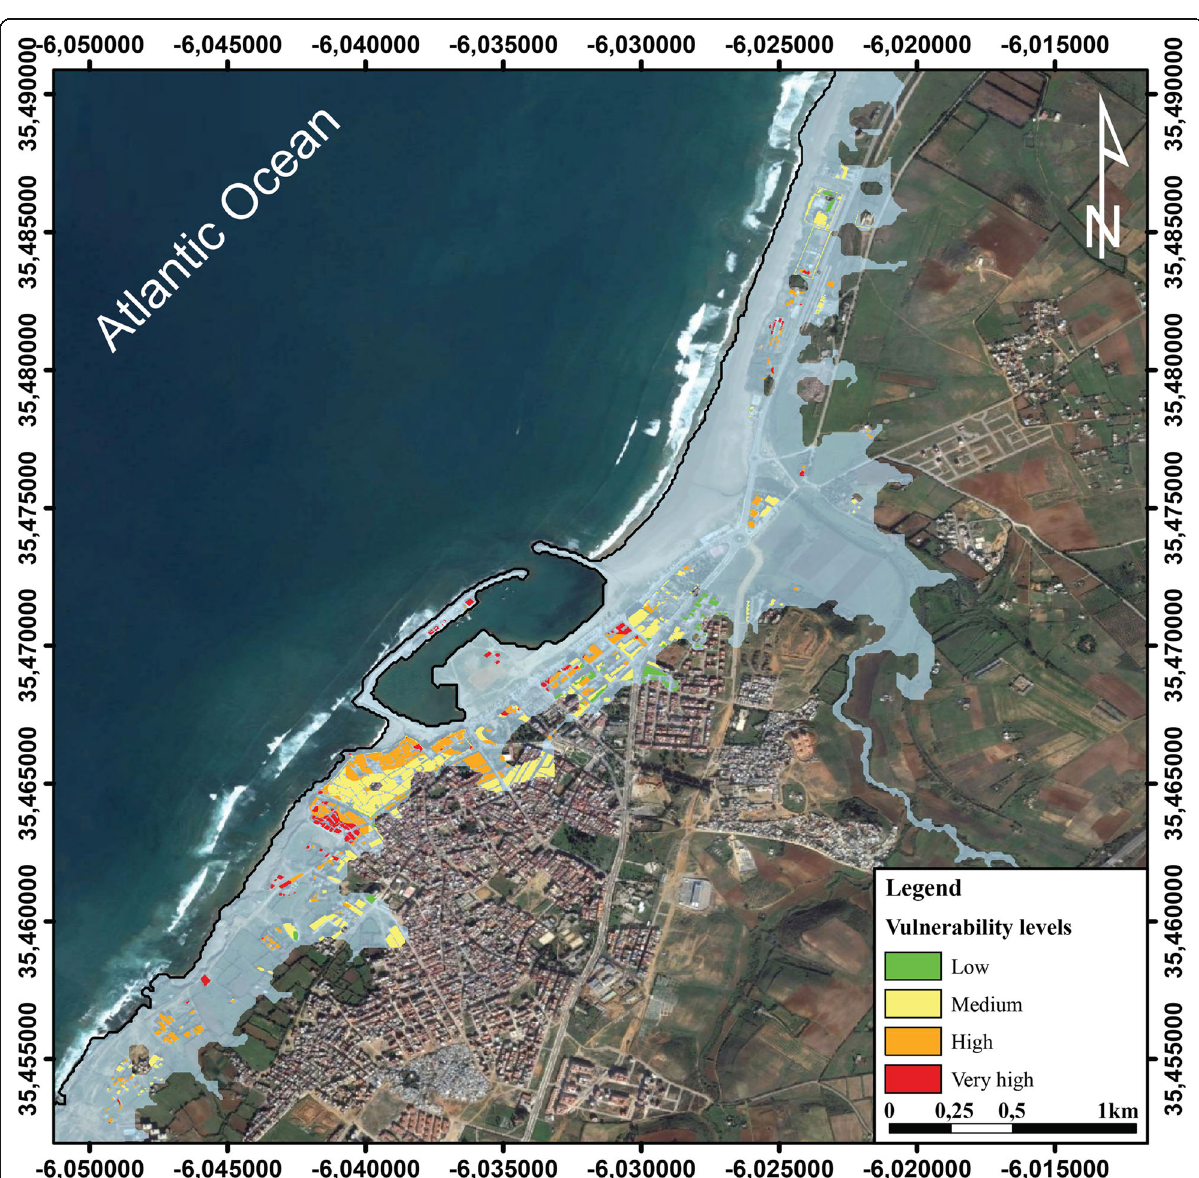
Fig. 6 Building tsunami vulnerability Map displaying the level of vulnerability caused by tsunami impact along the Asilah bay; the Low level corresponds to slight no structural damage, Medium corresponds to slight structural damage, High corresponds to severe structural damage, and Very high corresponds to a total